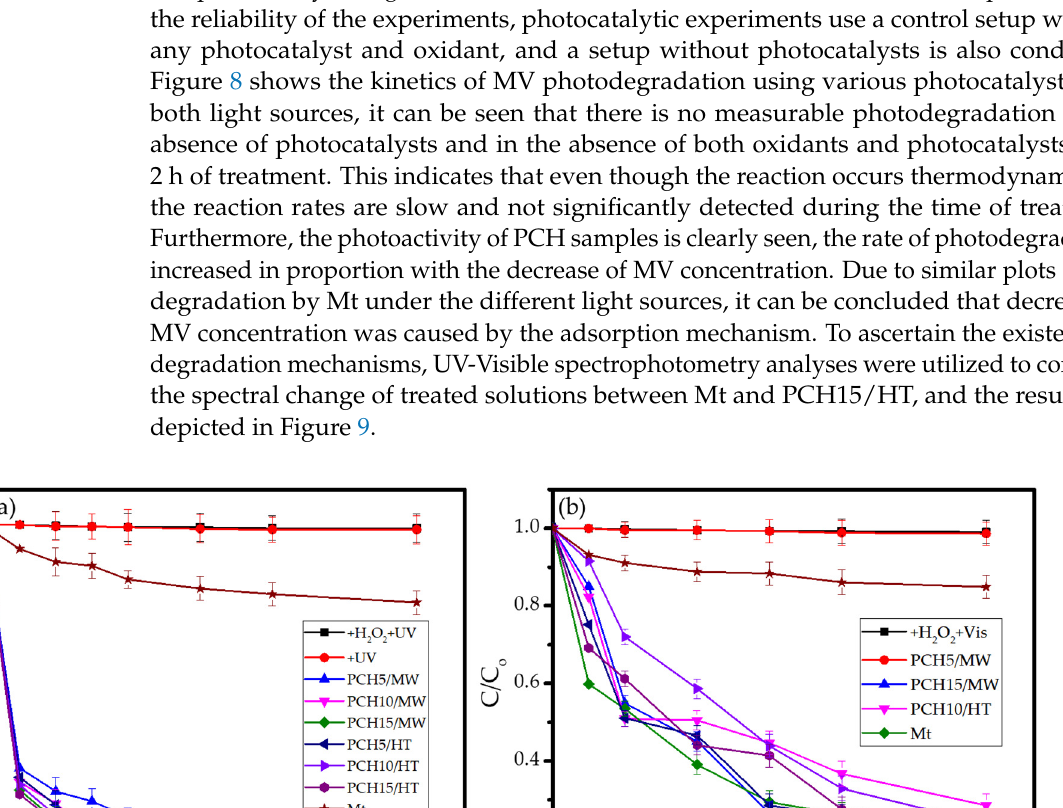
Figure 9. Comparison of UV ‐ Visible spectra of treated solution by adsorption and photodegradation mechanism. With the increasing time of treatment, the adsorption produces reduced absorbance spectra without any shifting of peaks. In contrast, the photocatalysis treatment resulted not only in reduced absorbance, but also in a blue shift from the characteristic peak at 586 nm. Typical blue shift is characteristic of the demethylation that was also investigated in photocatalytic degradation of MV by hematite/TUD ‐ 1 [42], MV by TiO 2 /Pd [42], methyl orange by CdS [43], and crystal violet by BaWO 4 nanorods [44]. The photodegradation rates varied with each photocatalyst, but, in general, the faster reaction occurred under irradiation with UV light rather than with visible light. Under UV light, the degradation efficiencies (DEs) reached more than 90% at 30 min over all PCH samples, while DEs of only 59% were achieved under visible light illumination. This indi ‐ cates that the photocatalytic mechanism exhibited by ZnO is a result of electron excitation under UV light and is faster compared to the degradation under visible light.